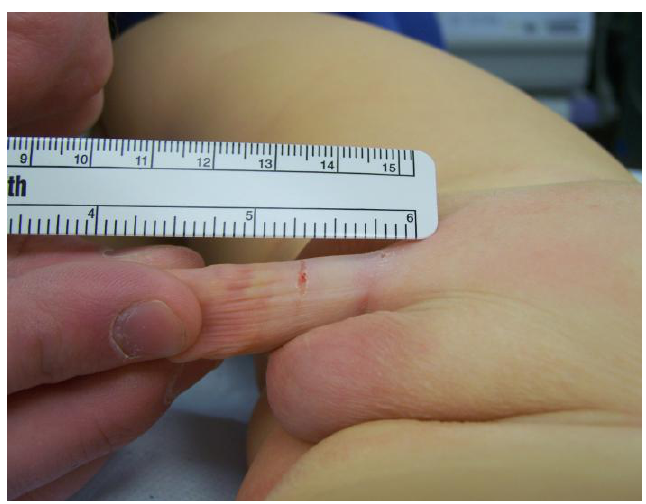
FIGURE 1. SPL is measured from the pubis to the tip of the stretched